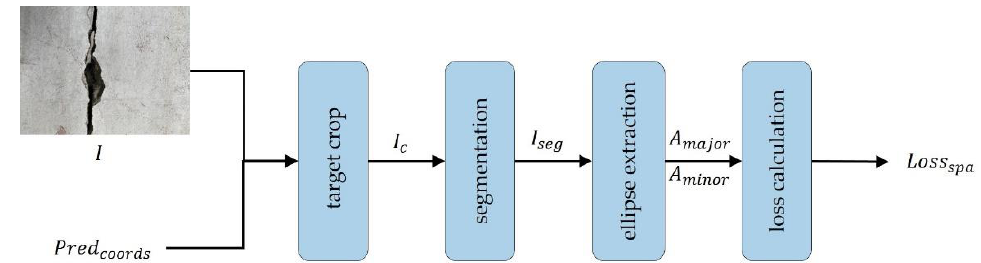
11 of 21 Figure 12. Structure of the 𝐿𝑜𝑠𝑠 𝑒𝑓𝑓 computation. 3.4. OASIS-Net Spalling Detection Spalling has a morphologically closed figure with an oval shape. The proposed loss produces an ellipse close to the defect. We calculated the ratio of the length of the major and the minor axes of the ellipse and compared it with the length ratio of the GT major and minor axes to calculate the loss. These functions can distinguish differences from other fault classes. Additional information can improve learning accuracy. The 𝐿𝑜𝑠𝑠 𝑠𝑝𝑎 is calculated as follows: